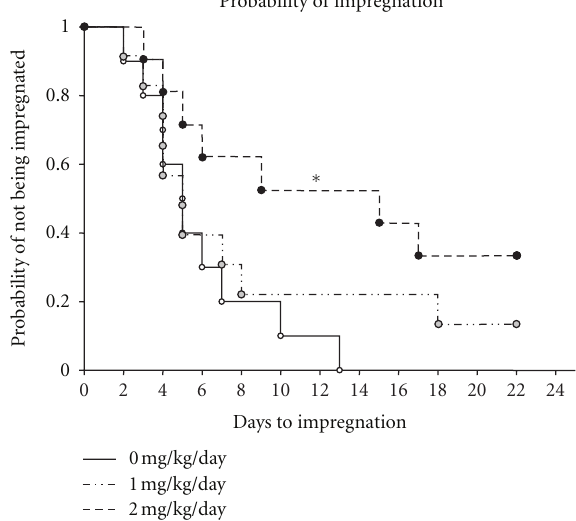
Figure 2: Kaplan-Meier survival curves. Probability of an exposed male impregnating an unexposed female. ∗ Indicates a significant di ff erence from the control group. P < 0 .